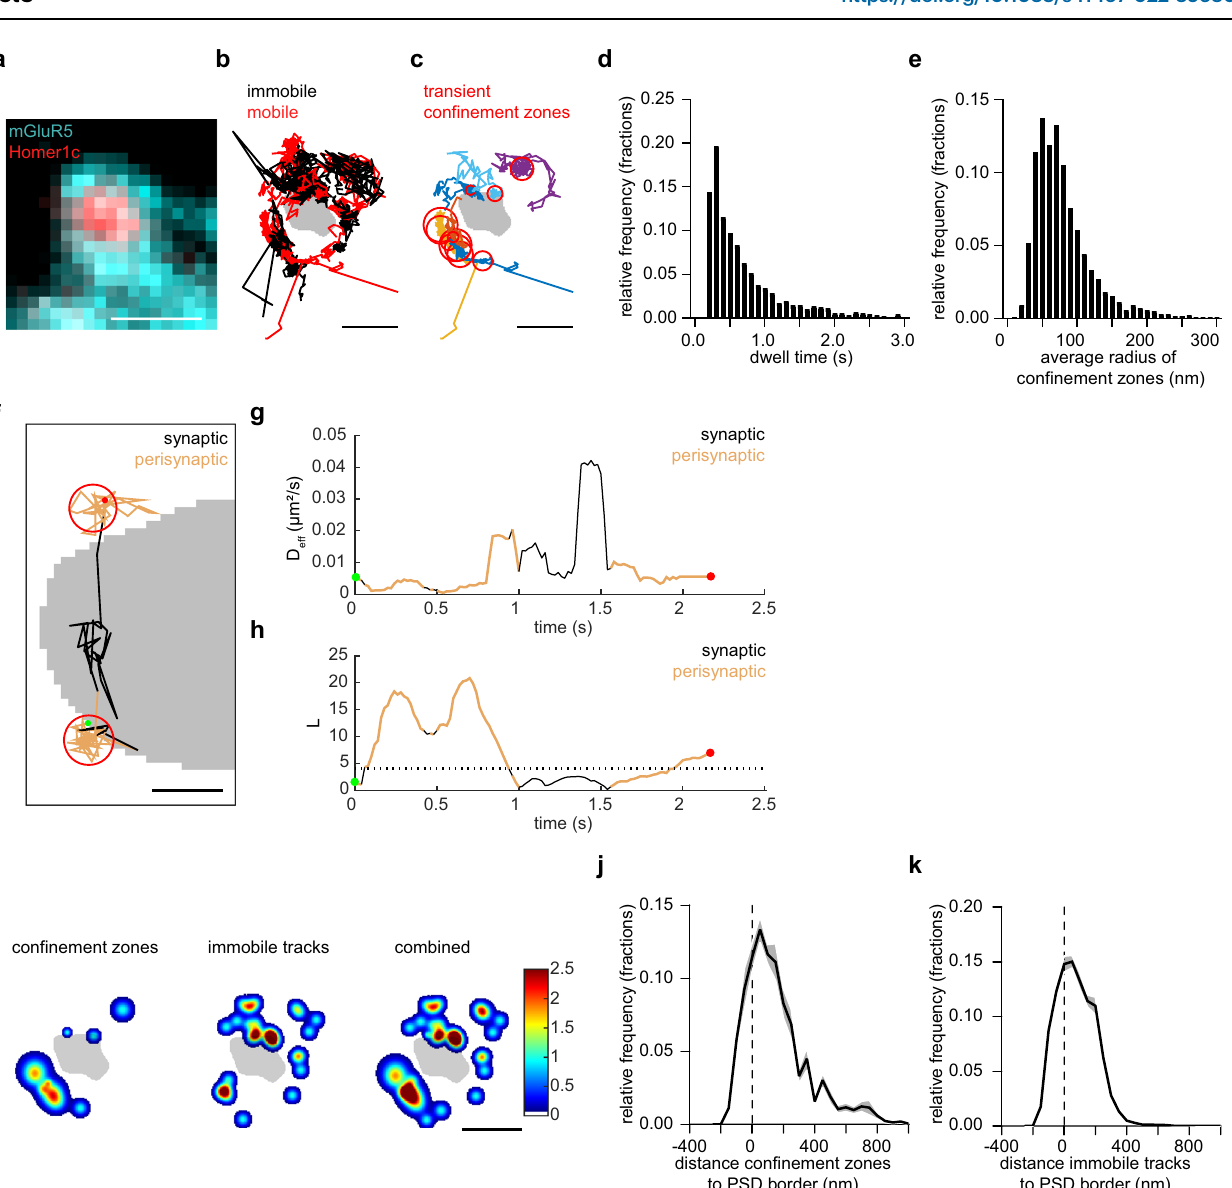
con fi nement zones. Scale bar, 100nm. g The diffusion coef fi cient and h con fi nementindex L overtimeforthetrajectoryshownin f ,usingthesamecolor- coding. i The same example synapse as in a – c with hotspots of transient con fi ne- ment zones, immobile tracks, and both images combined, color-coded for the frequency of con fi nement zones and/or immobile tracks (larger ROI shown in Fig. S4i). Scale bar, 500nm. j Relative frequency distribution of the distance of con fi nementzonesofmGluR5and k centerofimmobilemGluR5trajectoriestothe borderofthePSD(=0andindicatedbydashedline).Datainthis fi gureisthesame dataset as used in Fig. 3, as these fi gures show different aspects of the same experiment. Data are represented as means±SEM. Source data are provided as a Source Data fi